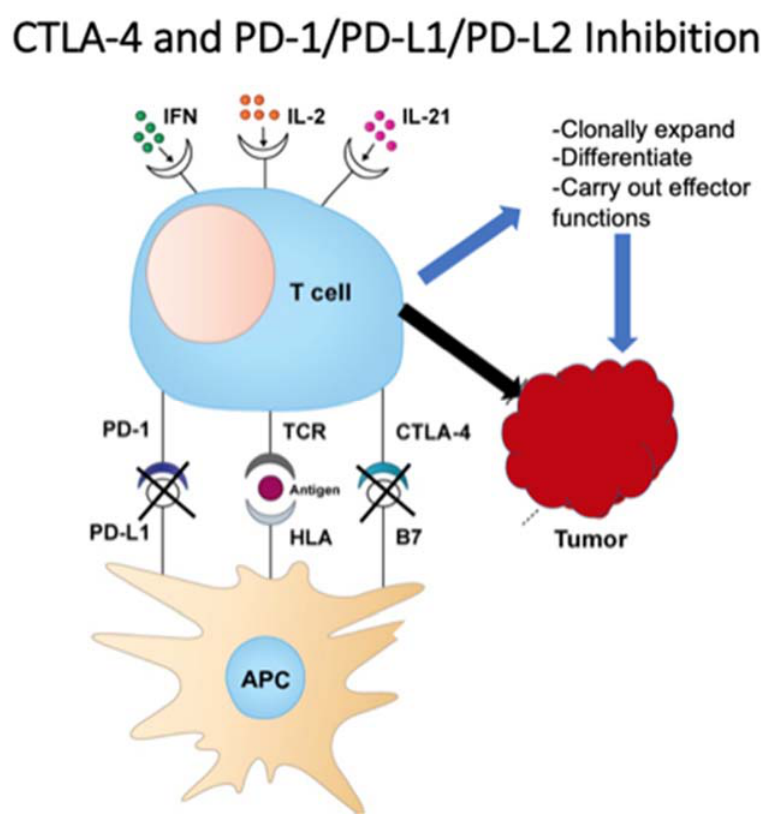
Figure 1. T cell function on tumor cells.